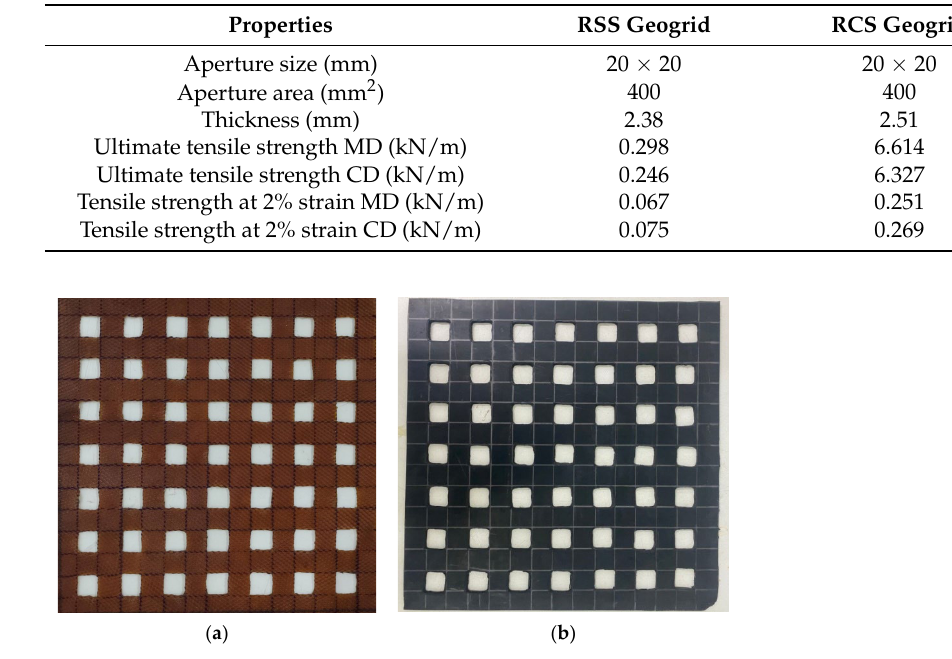
Table 2. Engineering properties of reinforcement material. Figure 3. Tensile strength ( a ) RSS geogrid ( b ) RCS geogrid.